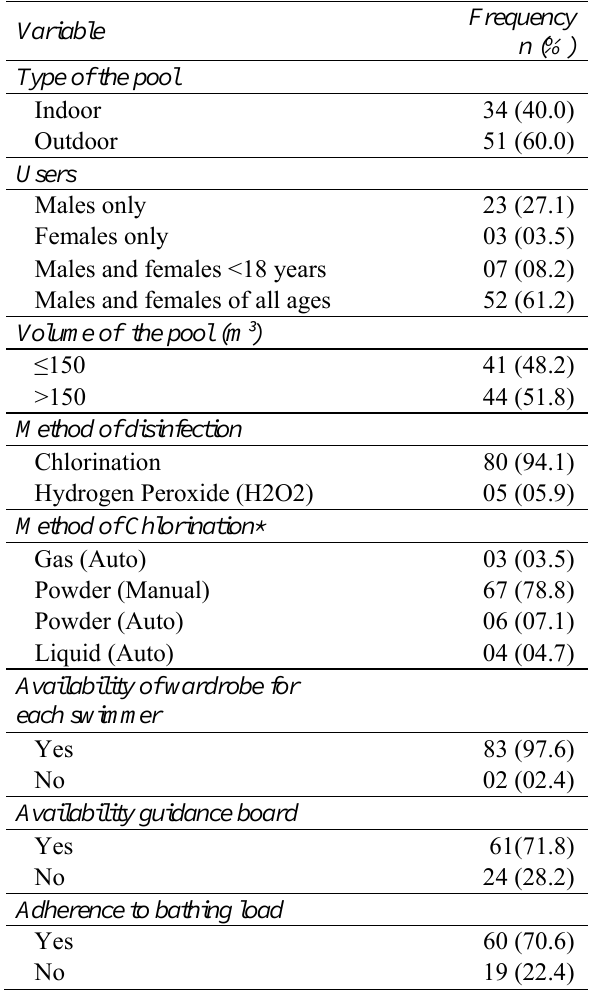
Table 1: Characteristics of the Public Swimming Pools in Amman/ Jordan